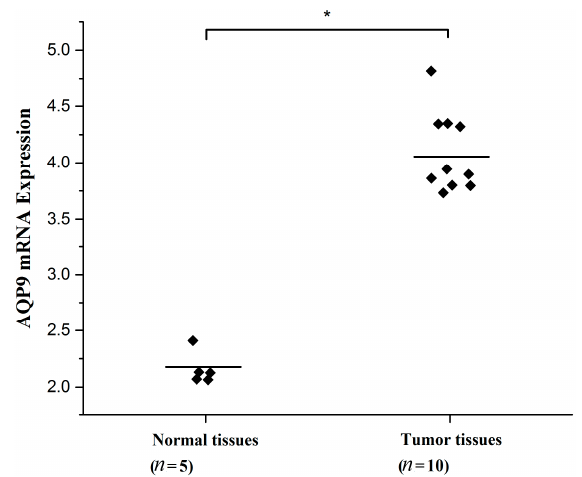
Figure 2. AQP9 expression was significantly increased in prostate cancer tissues when compared with the adjacent tissues of patients from GEO dataset GSE55945 ( p < 0.05 as compared with control). Bars represent means, * p < 0.05